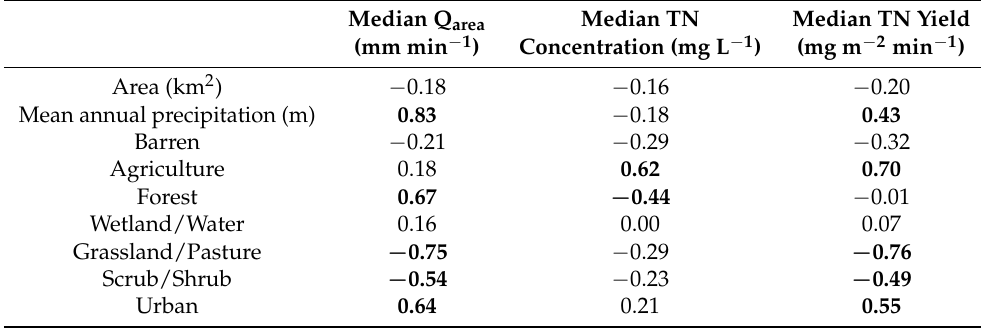
Table 5. Correlation (r) of Q area , TN concentrations, TN yields with catchment size, precipitation, and land cover